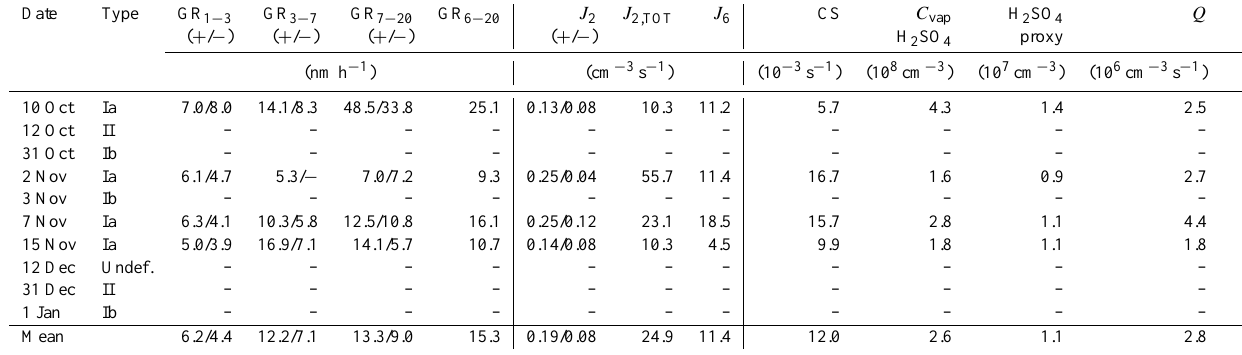
Table 2. Summary of observed new particle formation events between 10 October 2010 and 10 January 2011. They were classified according to Dal Maso et al. (2005). The growth rates (GR) and particle fluxes ( J ) with two values were calculated from ion spectrometer data for both polarities ( + and − ). J 2,TOT was calculated from corona-charged (negative) particles. The condensation sink (CS), vapour concentration ( C vap ) and production rates ( Q ) were calculated from DMPS data. The H 2 SO 4 proxy was calculated from SO 2 data (Pet¨aj¨a et al., 2009).